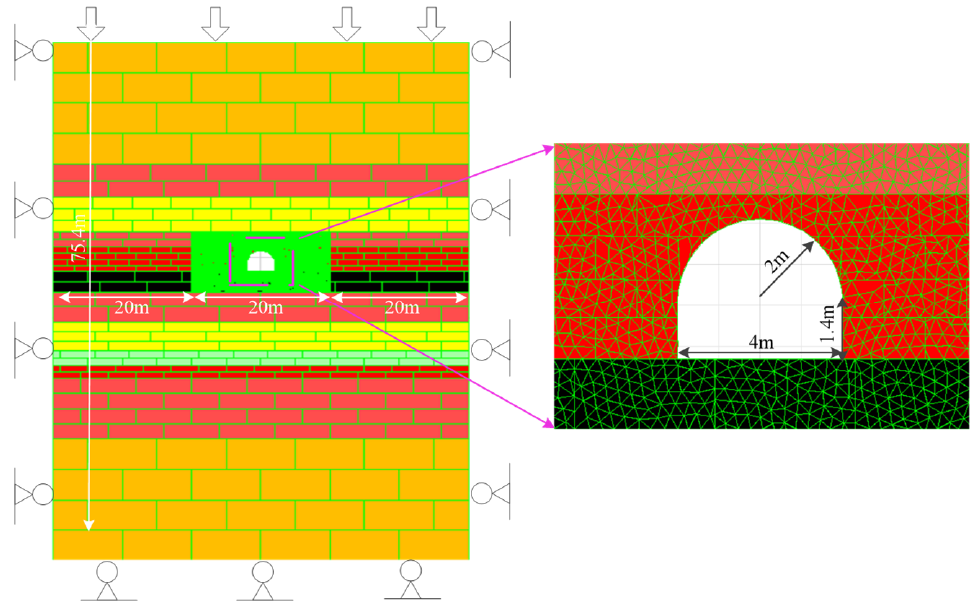
Figure 8. Numerical calculation model of Ⅱ 5 Rail Rise.